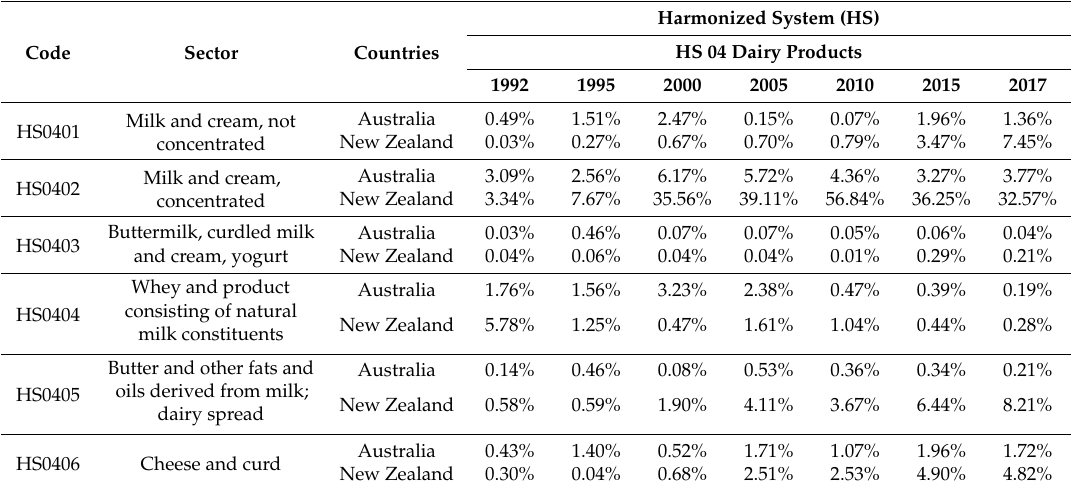
Table 4. Share of Australia and New Zealand in dairy market of